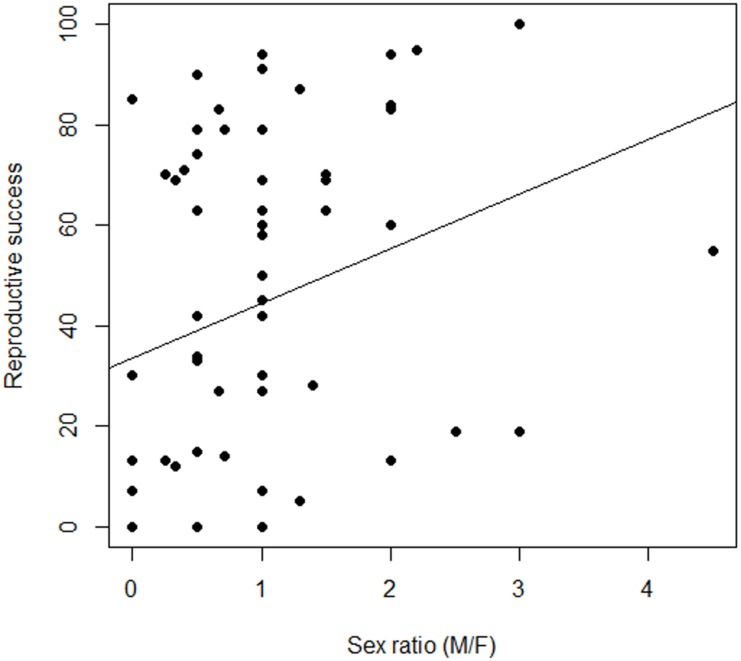
Variation in the relationship between reproductive success and sex ratio, males to females (M/F), in Z. portoricensis.Linear regression: \documentclass[12pt]{minimal}
\usepackage{amsmath}
\usepackage{wasysym}
\usepackage{amsfonts}
\usepackage{amssymb}
\usepackage{amsbsy}
\usepackage{upgreek}
\usepackage{mathrsfs}
\setlength{\oddsidemargin}{-69pt}
\begin{document}
}{}${r}_{\mathrm{adj}}^{2}=0.06$\end{document}radj2=0.06, F1,58 = 4.96, P < 0.03).